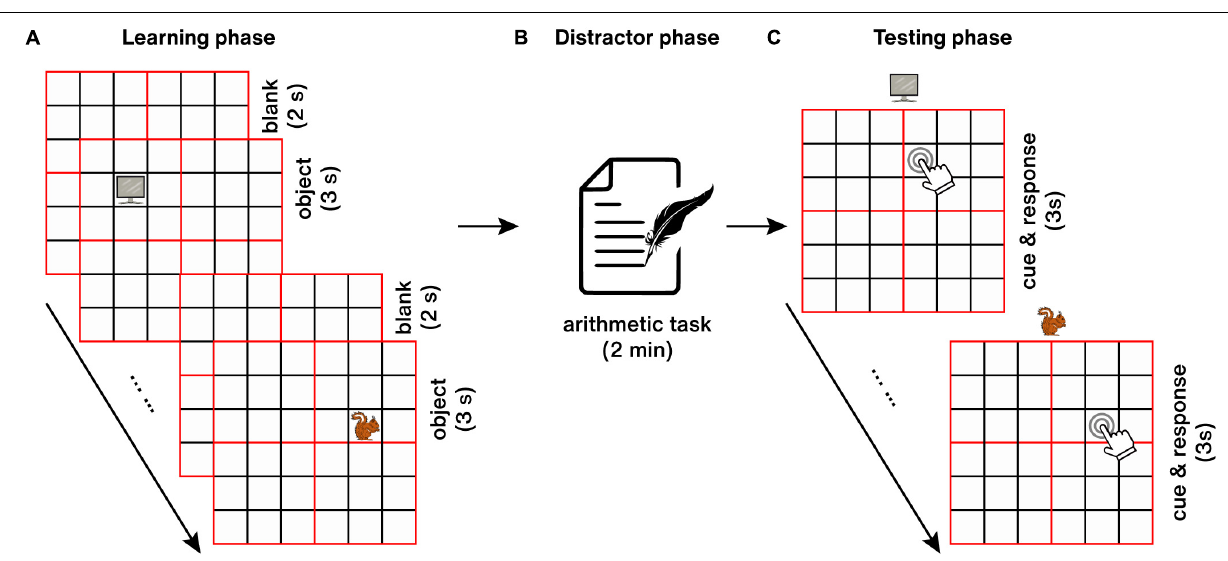
FIGURE 4 | Object-location spatial memory task. (A) Learning phase. (B) Distractor phase. (C) Testing